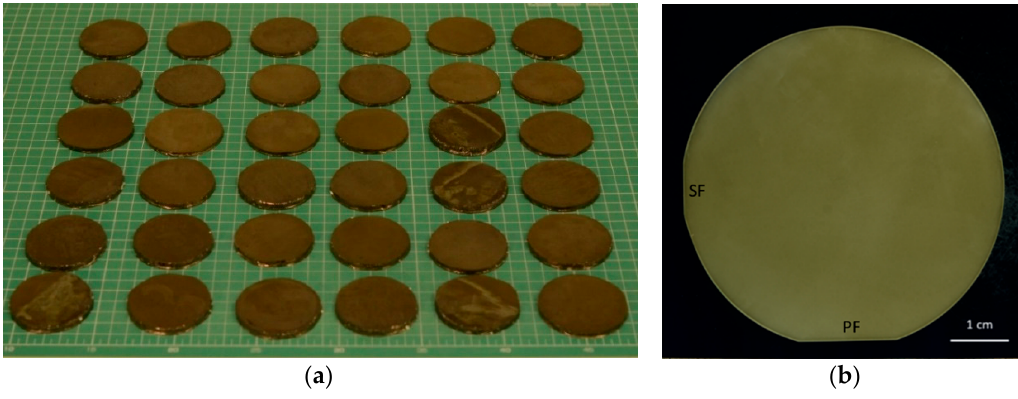
Figure 6. Examples of as-grown Am-GaN crystals of different shape: ( a ) ‘old’ hexagonal ( b ) ‘new’ round.